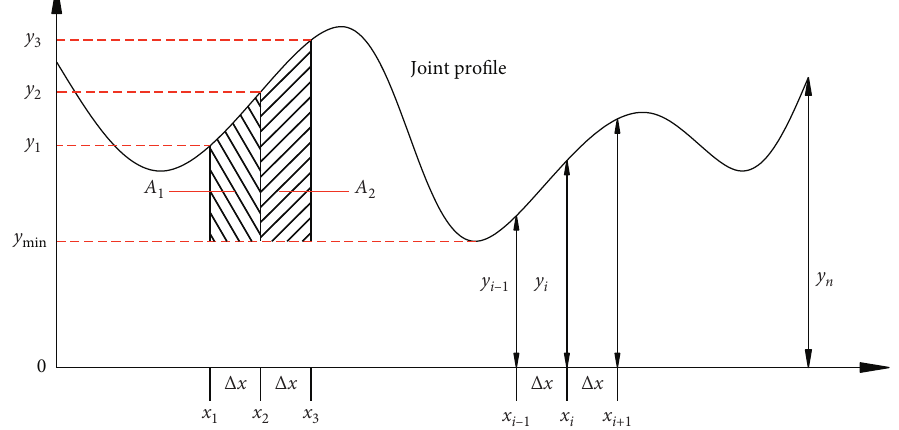
Figure 8: The diagram used to define the local area.